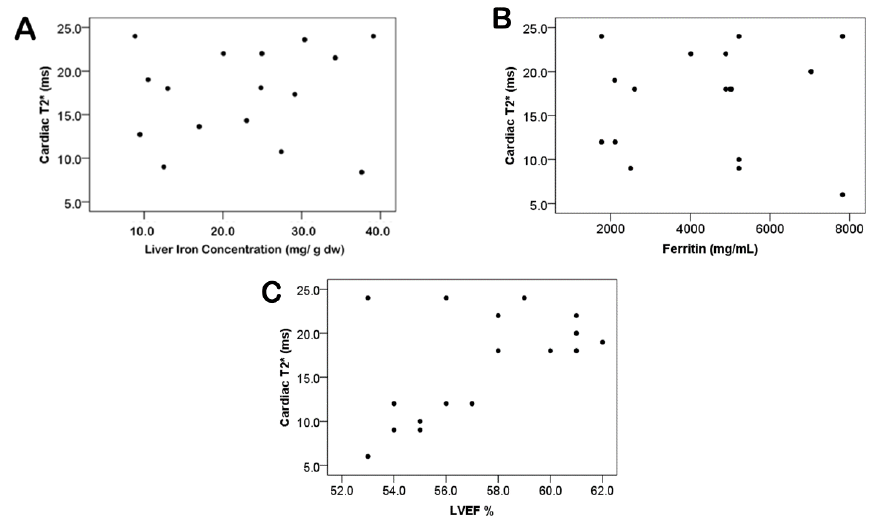
Figure 3 . No significant correlation between cardiac T2 * MRI and liver iron concentration ( A ) p = 0 . 39, serum ferritin ( B ) p = 0 . 54, and left ventricular ejection fraction ( C ) p = 0 . 09